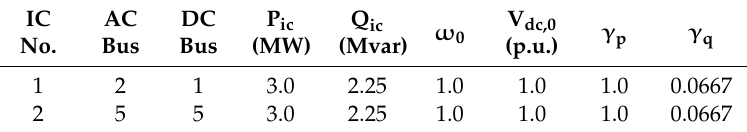
Table 10. The data for the IC of the 12-bus IHMG system.